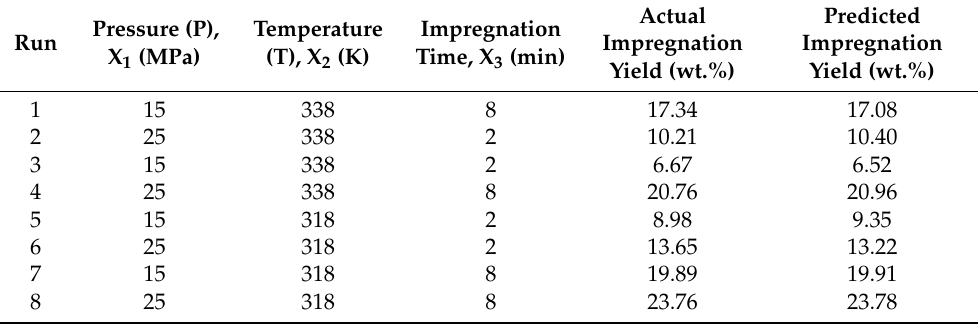
Table 3. Actual variables used in the FFD and impregnation yields of EO in PLA